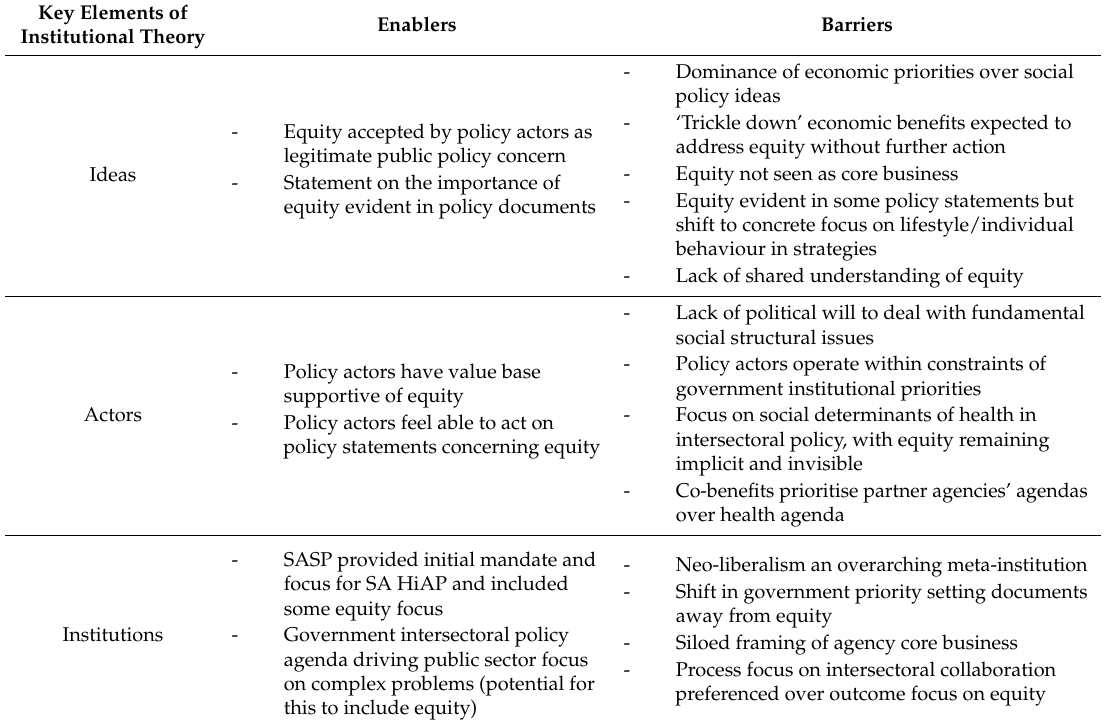
Table 5. Summary of findings on enablers and barriers to progression of equity by SA HiAP. Key Elements of Institutional